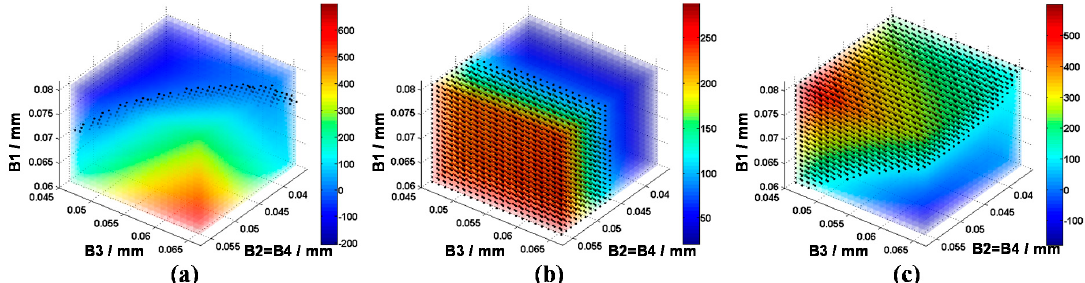
Figure 8. The relationship of geometric parameters B1,B2,B3,B4 and stiffness differences. ( a ) The stiffness difference between the two operation modes; ( b ) The stiffness difference between the in-phase drive mode and the anti-phase drive mode; ( c ) The stiffness difference between the in-phase sense mode and the anti-phase drive mode.